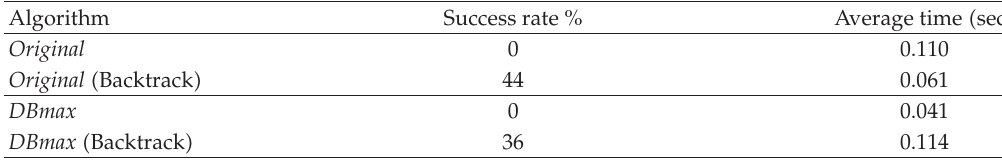
Table 5: Success rates and average times on